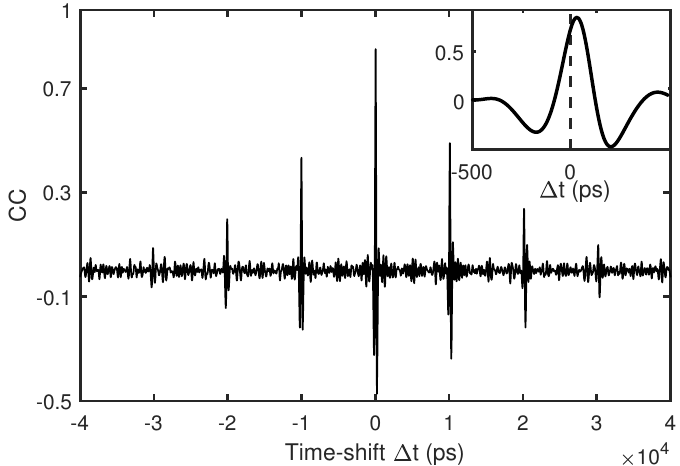
Figure 3. Cross-correlation coefficient between transmitter and receiver laser for κ = 9 ns − 1 , η = 15 ns − 1 , ∆ f = 0, τ ext = 10 ns, and τ f = 0. The inset figure shows the expanded version of CC plot near zero in time scale. The intra-cavity propagation delay τ PD is found to be 32.8 ps.